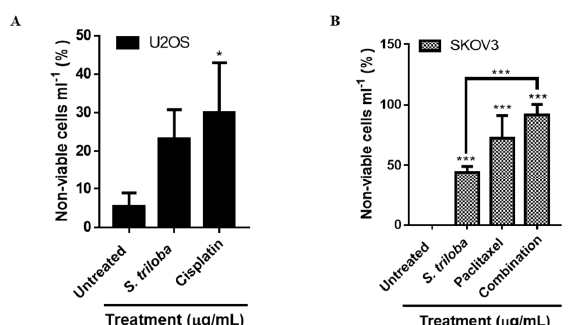
for U2OS and SKOV3 cells respectively (Figure 5).